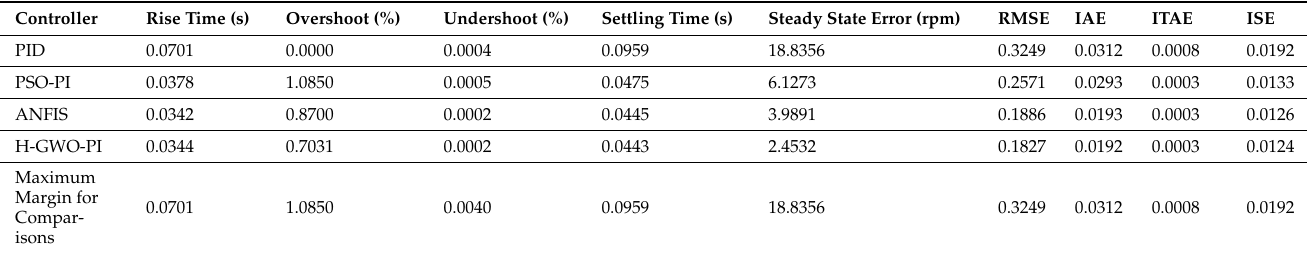
Figure 10. Speed response of the brushless dc motor under full load condition. Table 2. Full load condition’s performance parameters.